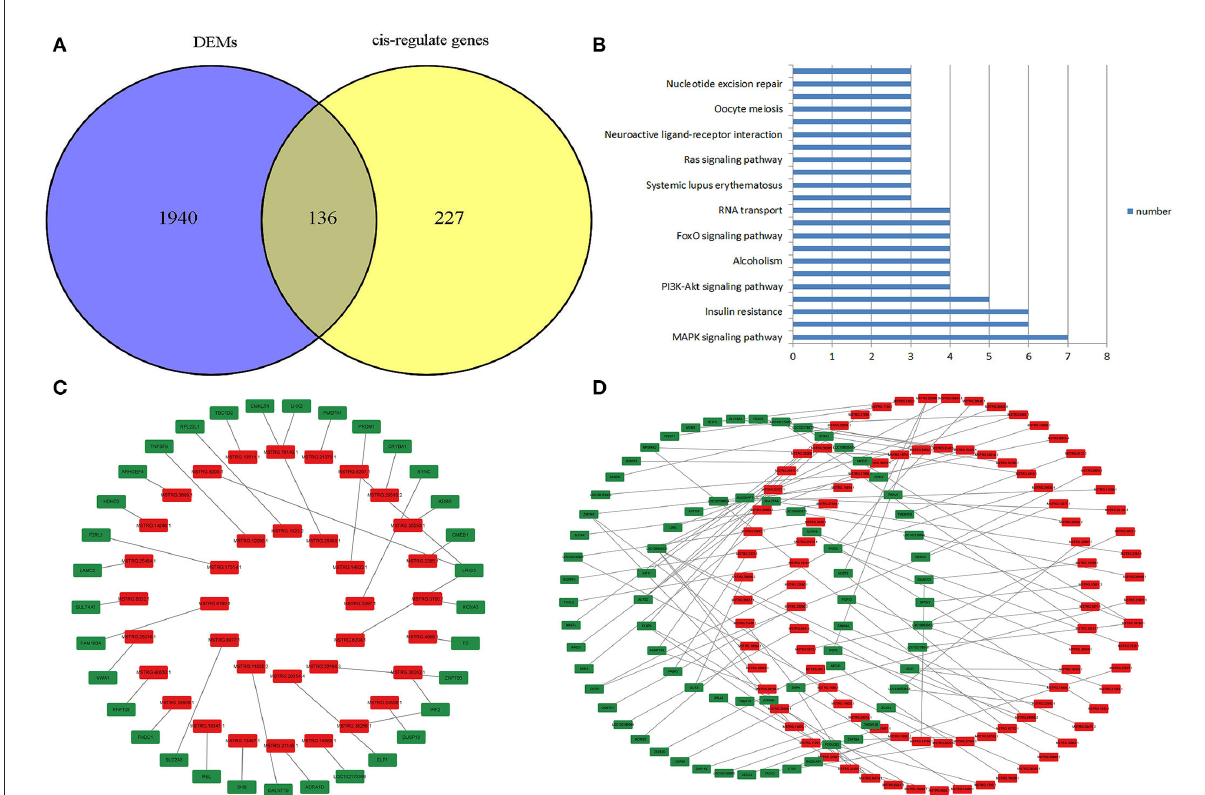
FIGURE6 Identification of the core lncRNA–mRNA network. (A) Venn plot of cis -genes of DELs overlapped with DEMs. (B) Functional enrichment analysis of DELs that target DEMs. (C) Core negative regulatory DEL–DEM networks in melanocytes. (D) Core positive regulatory DEL–DEM networks in melanocytes; the red symbol marks the DELs, and green marks the